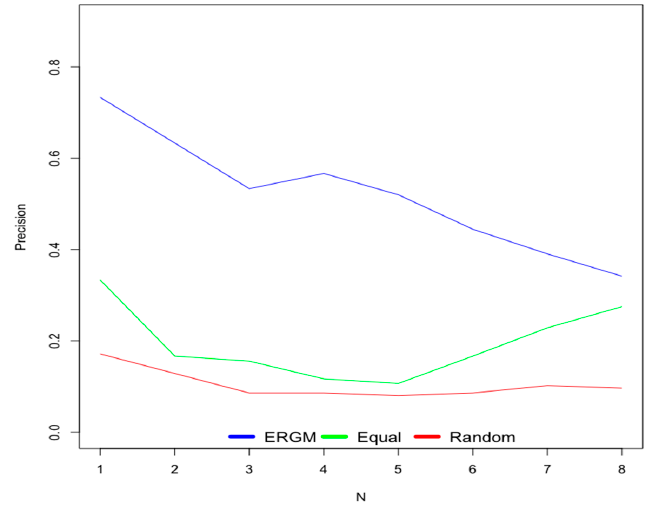
Figure 8. Precision for new users.